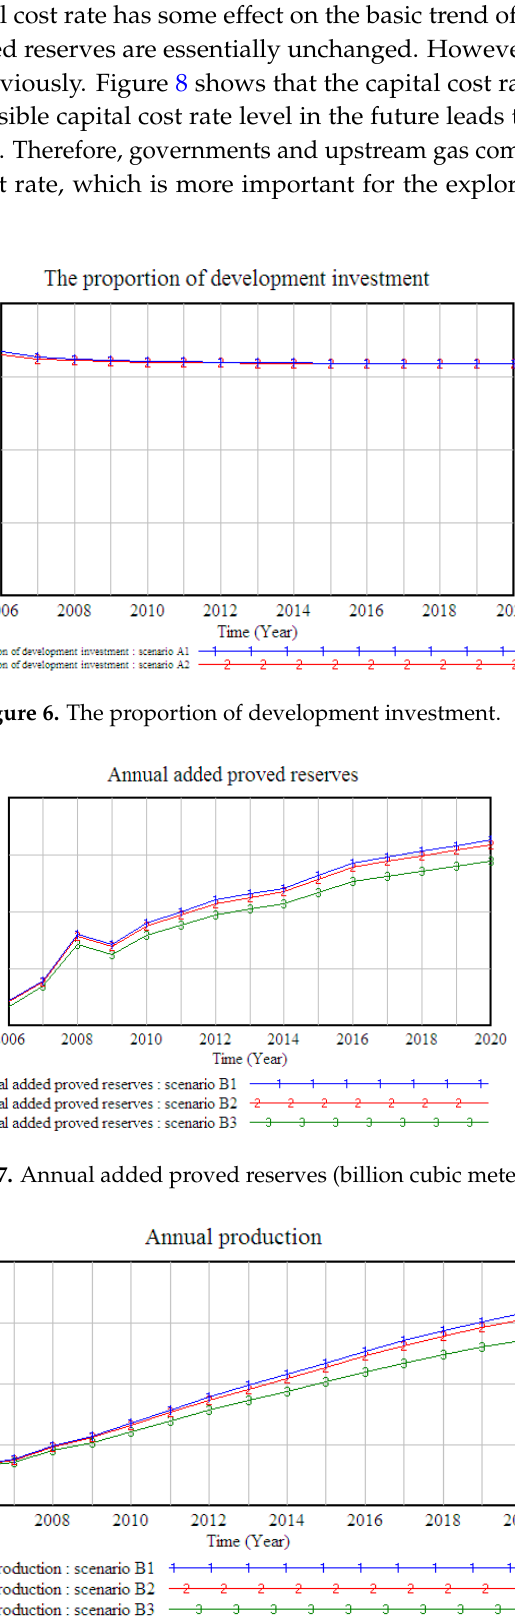
Figure 5. The proportion of exploration investment.